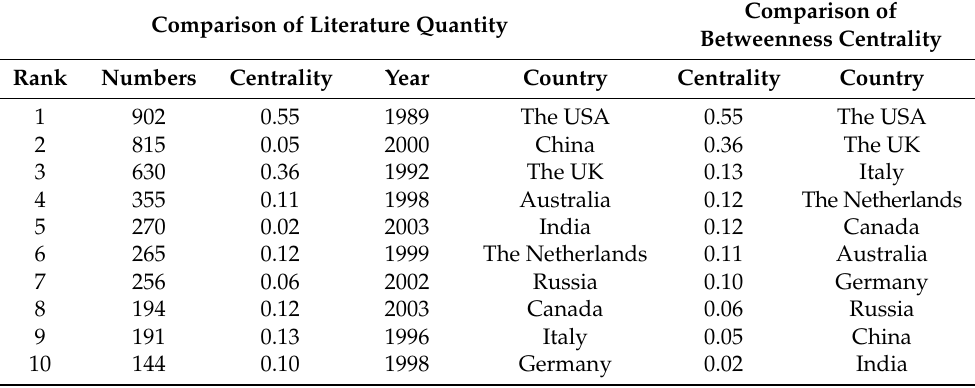
Table 1. Comparison of Literature Quantity and Betweenness Centrality in Top 10 Countries. Comparison of Literature Quantity